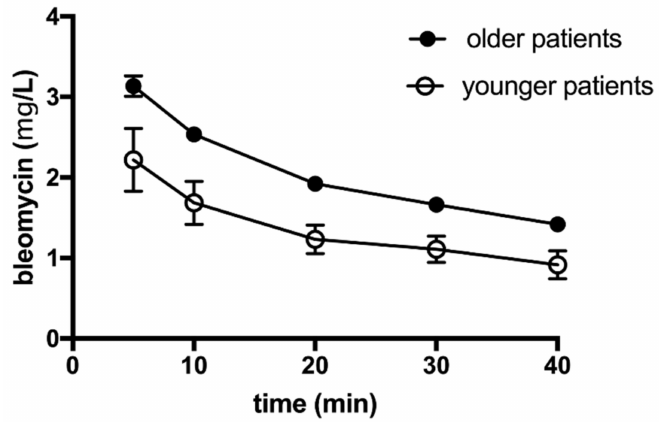
Figure 1. The elimination of bleomycin from the plasma of patients younger and older than 65 years after intravenous bolus injection of 15,000 IU/m 2 bleomycin dose. The points represent the mean +/ − SEM value determined in 12 patients. The graph for older patients has already been published, but due to direct comparison, we present the data on the same graph (with